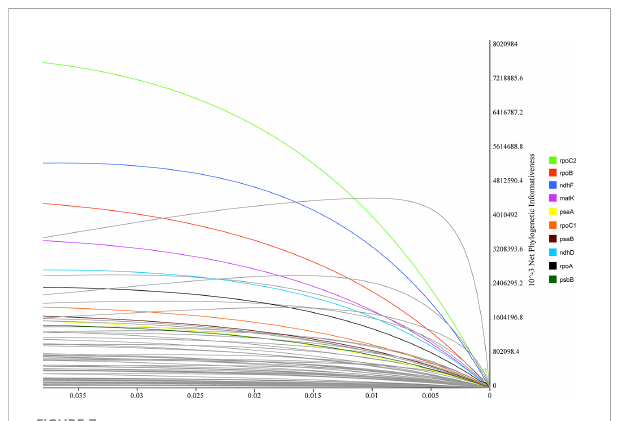
FIGURE 7 Phylogenetic net informativeness pro fi les of 74 protein-coding genes of Lobelioideae estimated using PhyDesign. Ten genes with the greatest informativeness are color-coded and indicated on the right. X- and Y-axes represent relative-time and net phylogenetic informativeness,